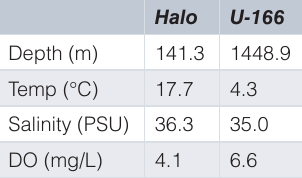
Table 1. Hydrographic conditions of water column samples collected proximate to two steel shipwrecks Halo and U-166 in the northern part of Gulf of Mexico. The depth, temperature, salinity and dissolved oxygen (DO) for the water samples collected from Halo and U-166 are listed